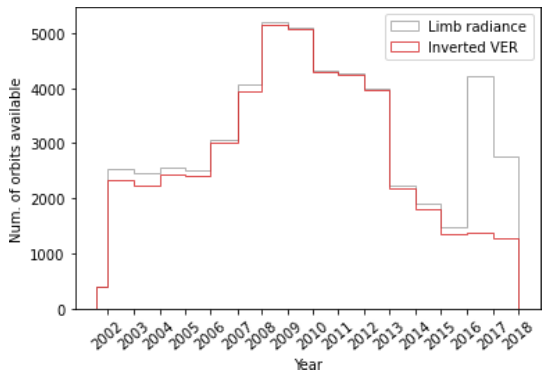
Figure 5. The averaging kernel (AVK) matrix of the first volume emission rate (VER) profile taken in orbit 10122 (see Fig. 7 for the whole orbit). (a) Every row of the AVK matrix, with those repre- senting the grid points between 60 and 95km (red) and those below and above this range (black). (b) The maximum of the AVK matrix in each row (refers to the bottom axis) and the altitude where such a maximum is found (refers to the top axis).